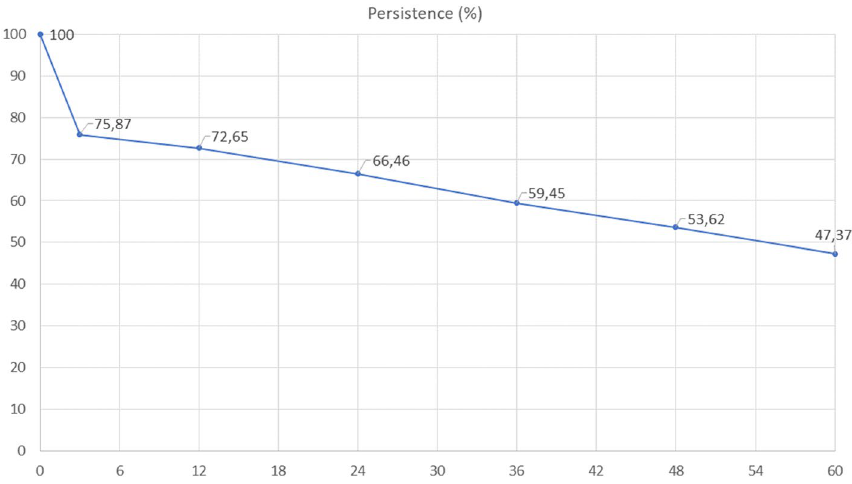
Figure 2. Persistence of treatment with antiosteoporosis medication over the 5-year follow-up period. 100% of patients were recommended antiosteoporotic treatment. Edited with Microsoft 365 A3 for faculty.